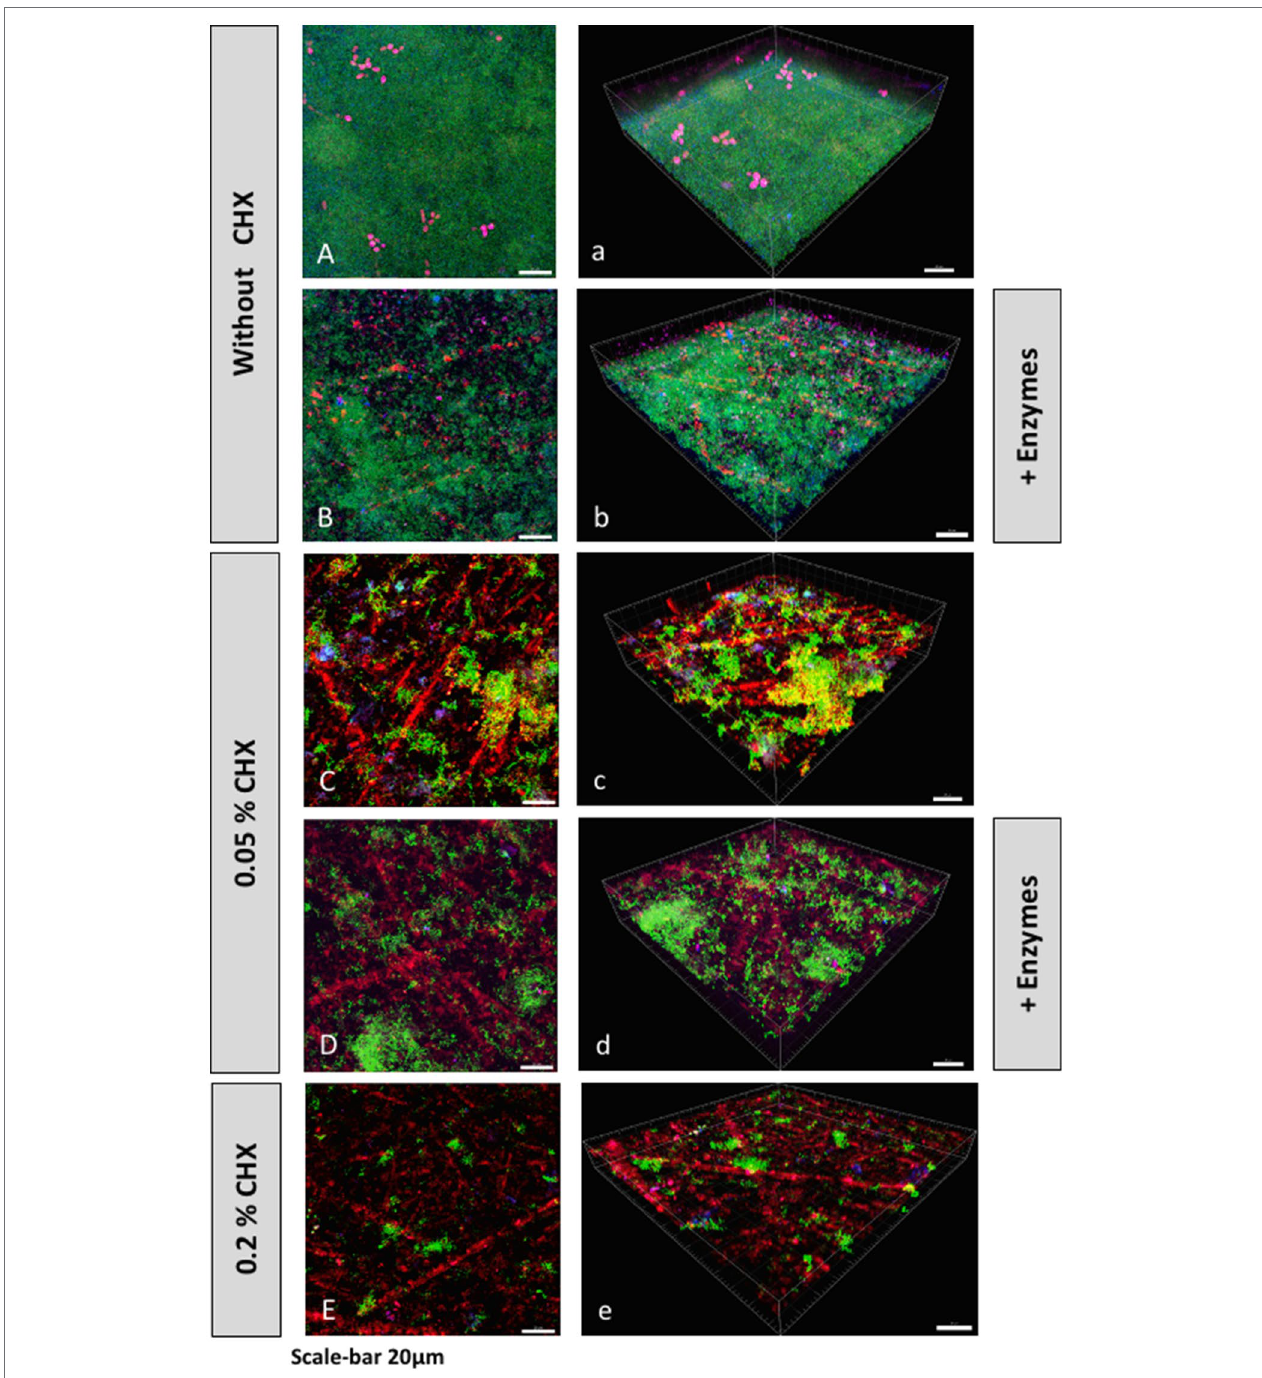
FIGURE 2 | Confocal laser scanning microscopy (CLSM) Z-stack maximum projections (A–E) and 3D reconstructions (a–e) of biofilms grown on HA disks after treatment with or without CHX and/or DNase I + proteinase K. Total DNA (green) was stained with a mixture of YoPro 1 and SYTOX ™ Green. Extracellular polysaccharides (blue) were stained with Calcofluor. Extracellular DNA (eDNA; red) was stained with Cy3-streptavidin labeled anti-DNA-antibody, and extracellular proteins (purple) were stained with SYPRO ™